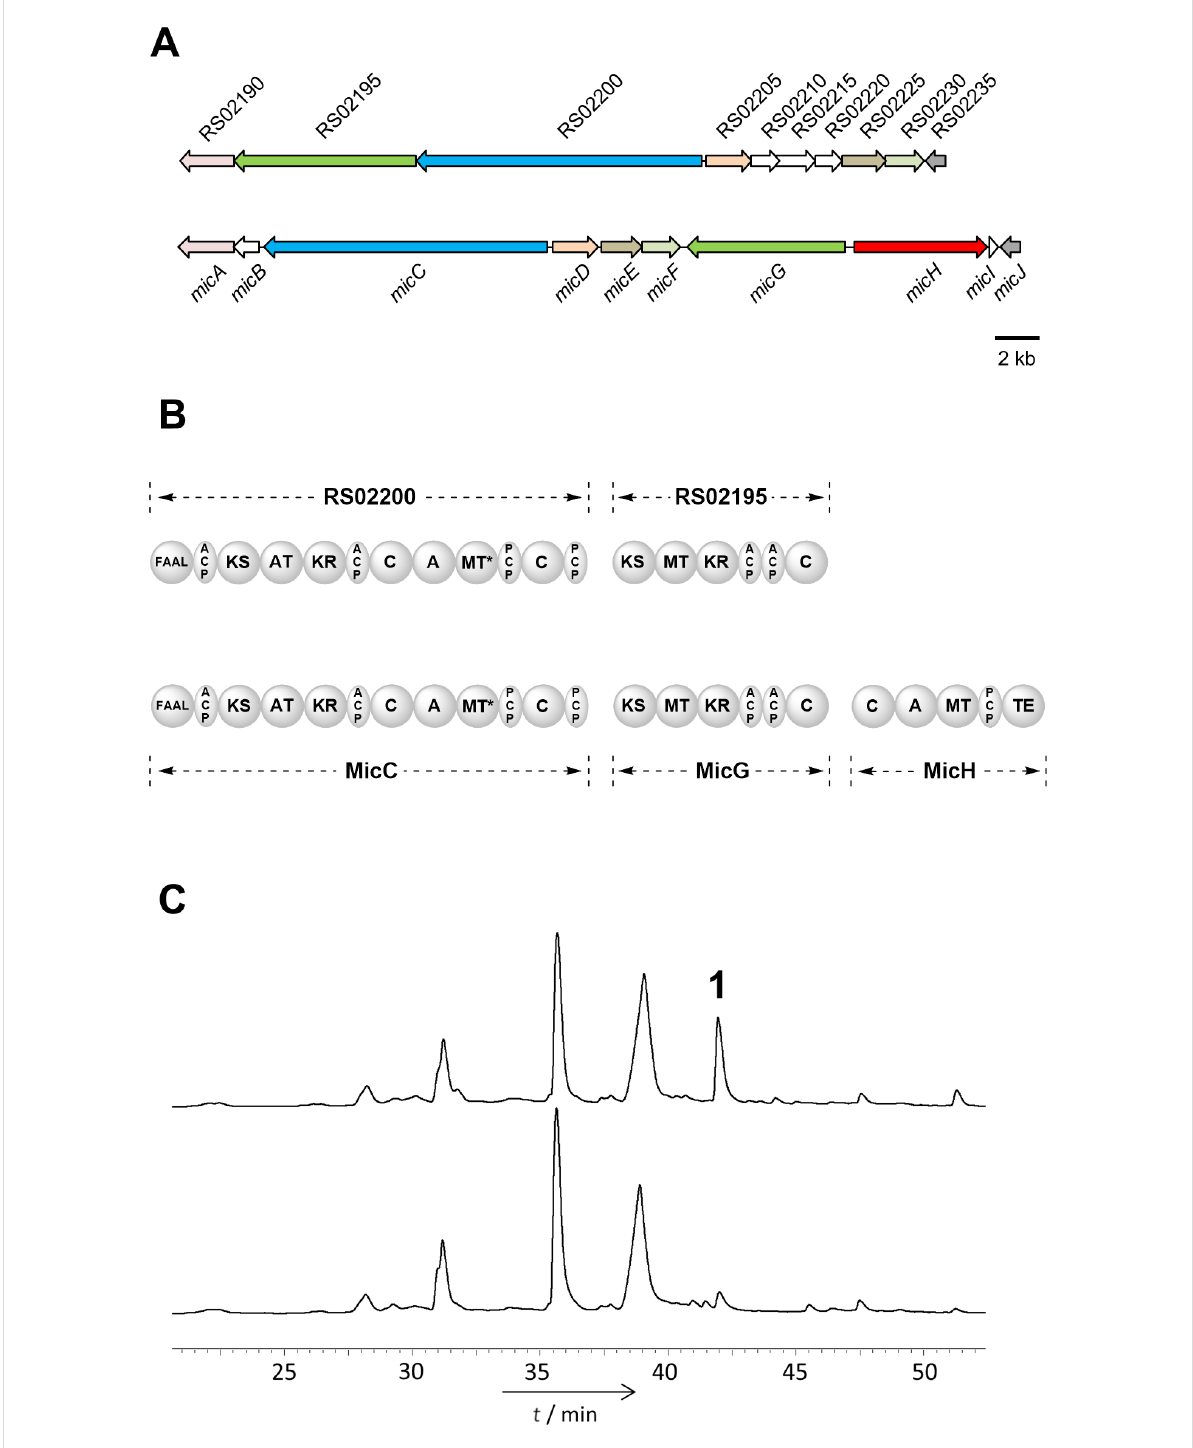
Figure 1: A) Organization of the micacocidin-type gene cluster from Massilia sp. NR 4-1 (top) and of the mic gene cluster from R. solanacearum GMI1000 (bottom). The open reading frames are color-coded according to their predicted function. B) Domain architecture of the massiliachelin (top) and the micacocidin (bottom) assembly lines. Domain notation: FAAL, fatty acyl-AMP ligase; ACP, acyl carrier protein; KS, β -ketoacyl synthase; AT, acyltransferase; KR, ketoreductase; C, condensation; A, adenylation; MT, methyltransferase; PCP, peptidyl carrier protein; TE, thioesterase. The asterisk indicates a methyltransferase-like epimerization domain. C) UV chromatograms of crude culture extracts from Massilia sp. NR 4-1 grown under iron-deficient (top) and iron-replete (bottom) conditions. The chromatograms were recorded at a wavelength of 274